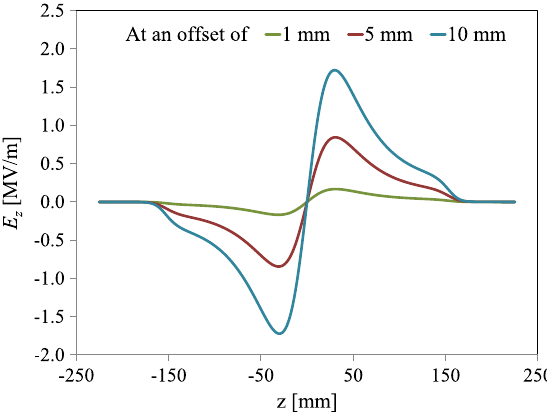
FIG. 8. Evolution of the parallel-bar cavity geometry into the rf-dipole geometry and cross sections of each